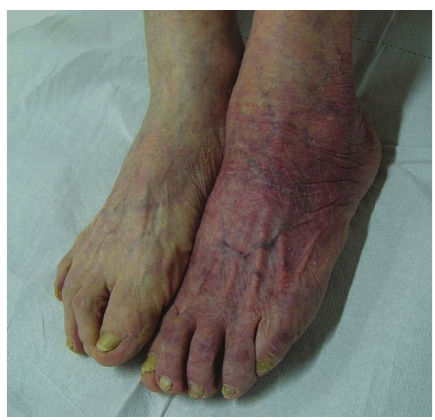
Figure 4: Acrodermatitis chronica atrophicans.